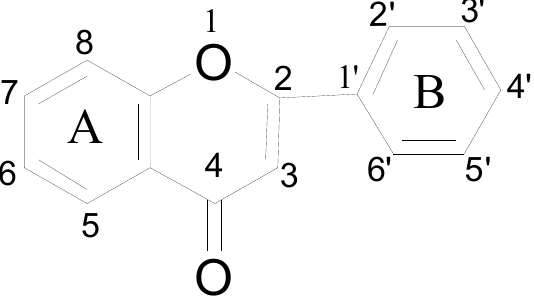
Figure 6. Chemical structure of flavonoids used in the present study.